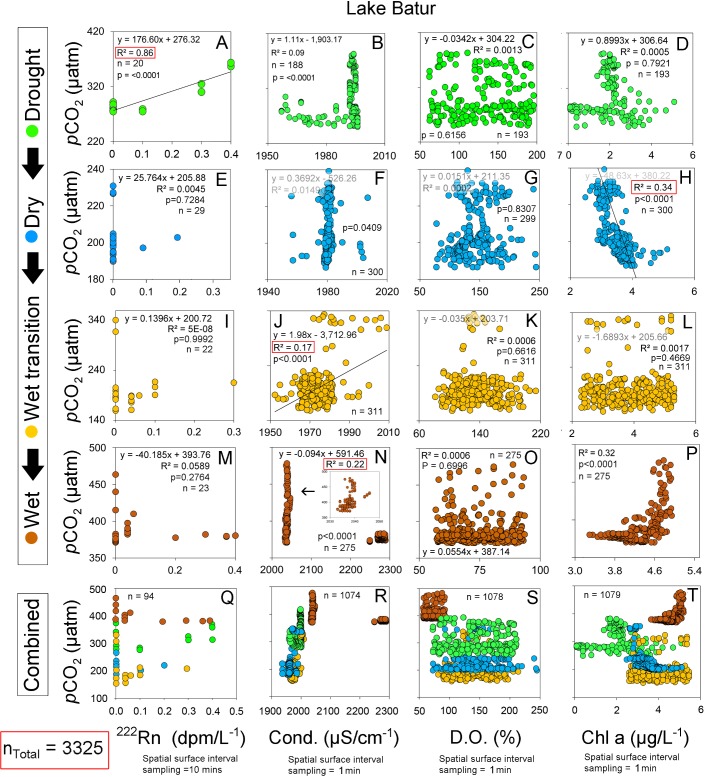
Relationships between pCO2 and 222Rn (groundwater tracer), conductivity, dissolved oxygen and chlorophyll a (from left to right) in the natural lake (Lake Batur).